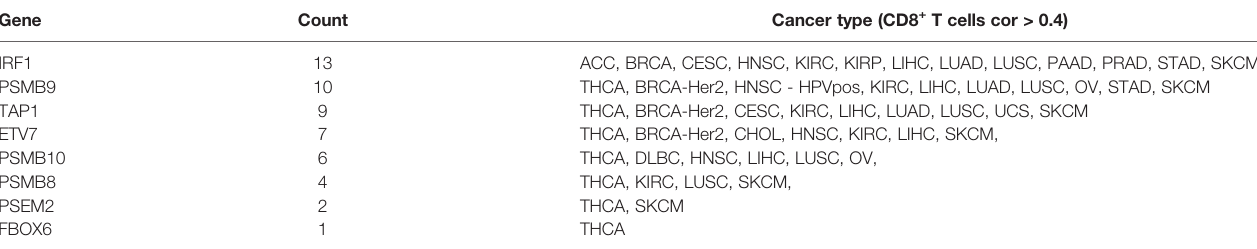
TABLE 5 | Correlation Analysis of Candidate Factors and CD8 + T cells. Gene